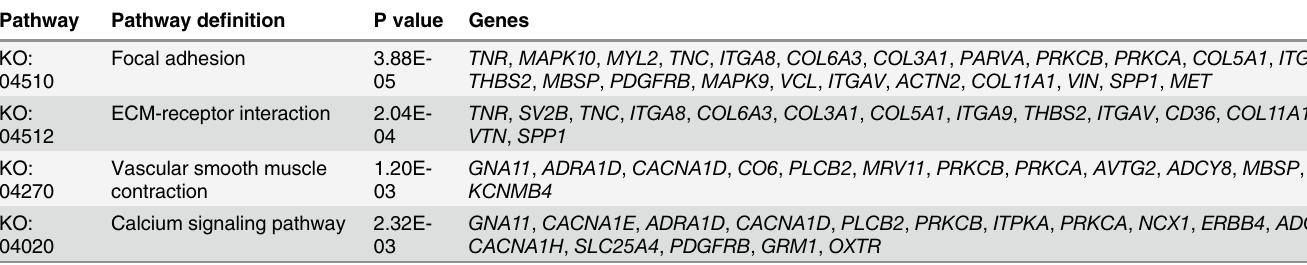
Table 2. KEGG pathway enriched in differentially expressed